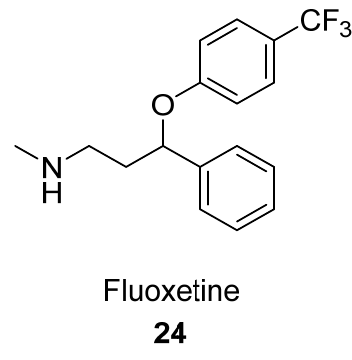
Figure 13. Structure of fluoxetine.